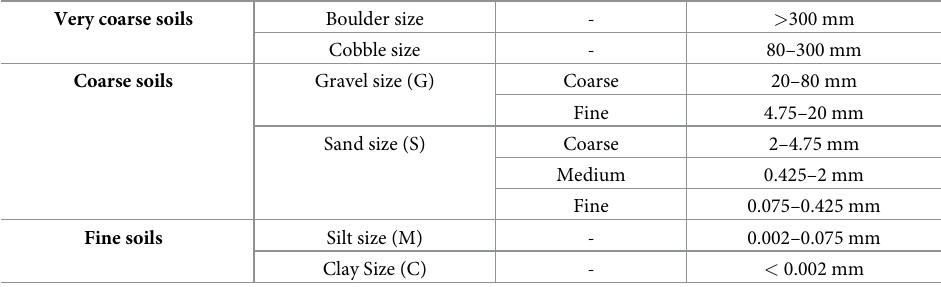
Table 8. Grain size classification by Indian Standard Soil Classification System.